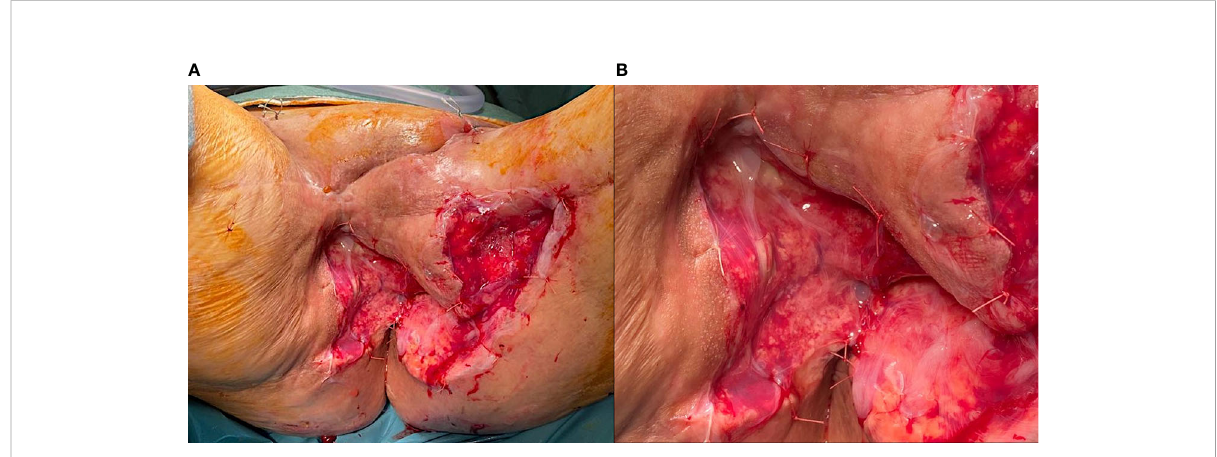
FIGURE 2 (A) Human amniotic membrane application. (B) Human amniotic membrane detail.